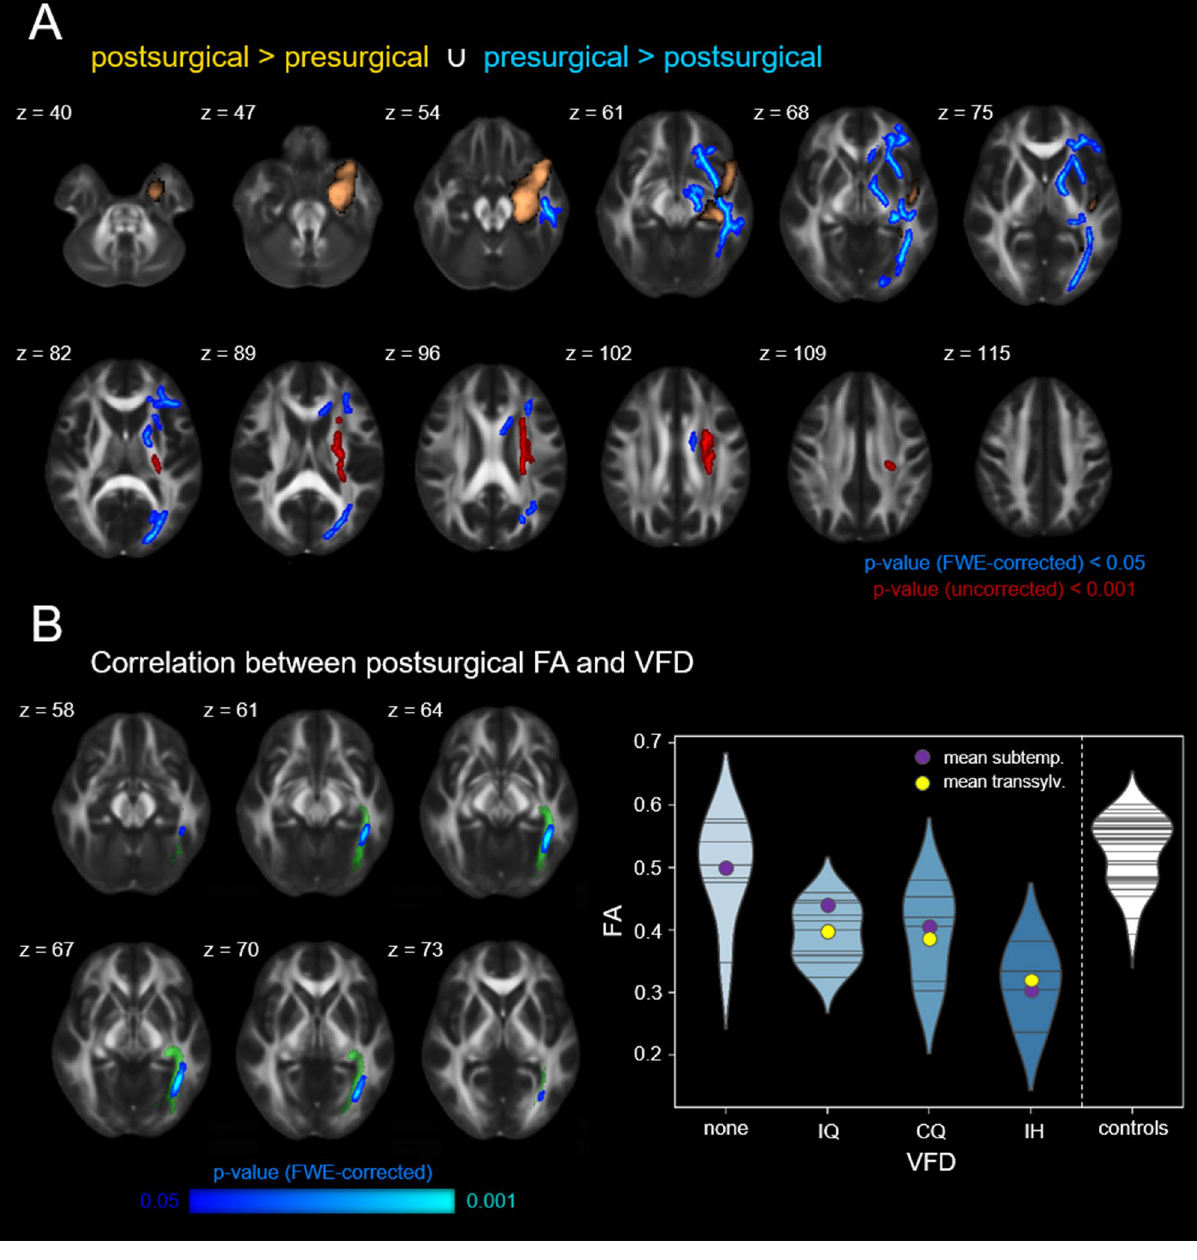
Figure 3. Tract-based spatial statistics results. ( A ) Comparison of fractional anisotropy in pre- and postsurgical FA maps of the transsylvian patient subgroup (FWE-corr. p < 0.05). ( B ) Correlation analysis between postsurgical fractional anisotropy and visual field deficit: the lower the fractional anisotropy, the larger the visual field deficit (FWE-corr. p < 0.05). The trajectory of the ipsilesional optic radiation as determined by probabilistic tractography is depicted in green. The canonical lesion mask is shown in bronze. Violin plots show the distributions of mean FA values within the significant cluster with each horizontal line representing the readout of one patient/control. z indicates axial level in MNI space. FA fractional anisotropy, IQ incomplete homonymous quadrantopia, CQ complete homonymous quadrantopia, IH incomplete homonymous